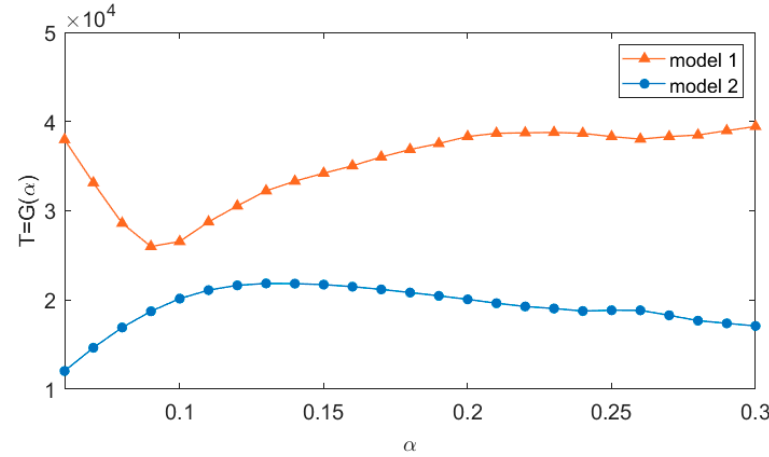
Figure 9. The image of the metric function ( ) T G α= of the models.